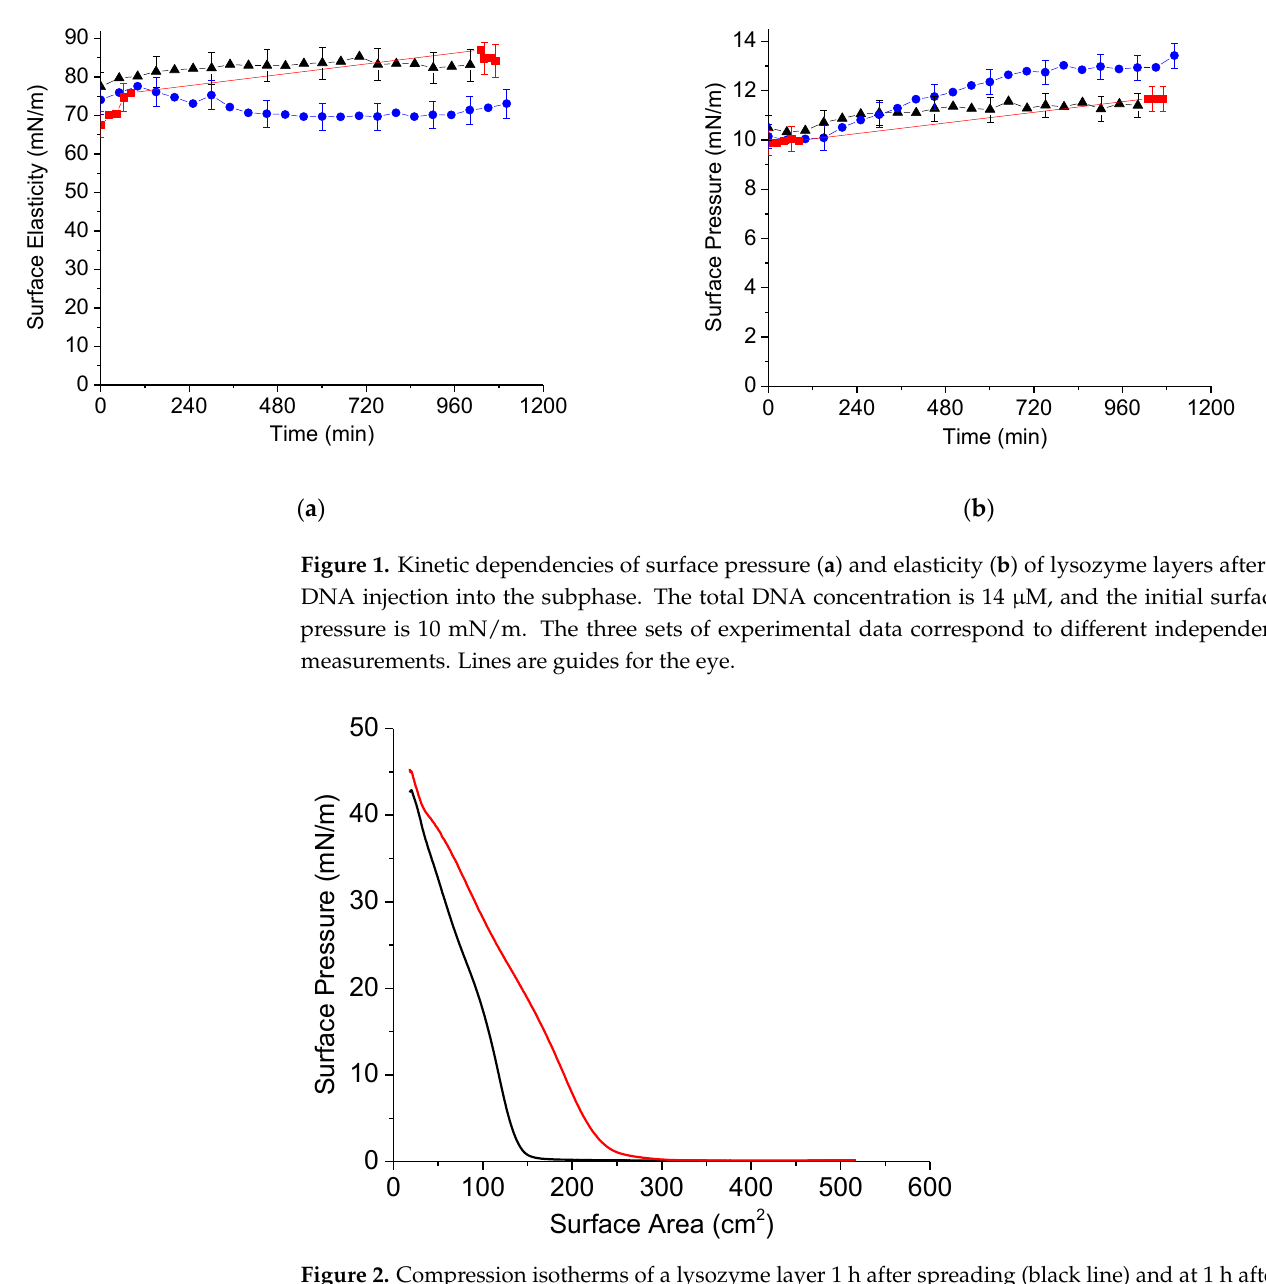
Figure 2. Compression isotherms of a lysozyme layer 1 h after spreading (black line) and at 1 h after spreading and a DNA injection (red line). The total DNA concentration is 50 μM.